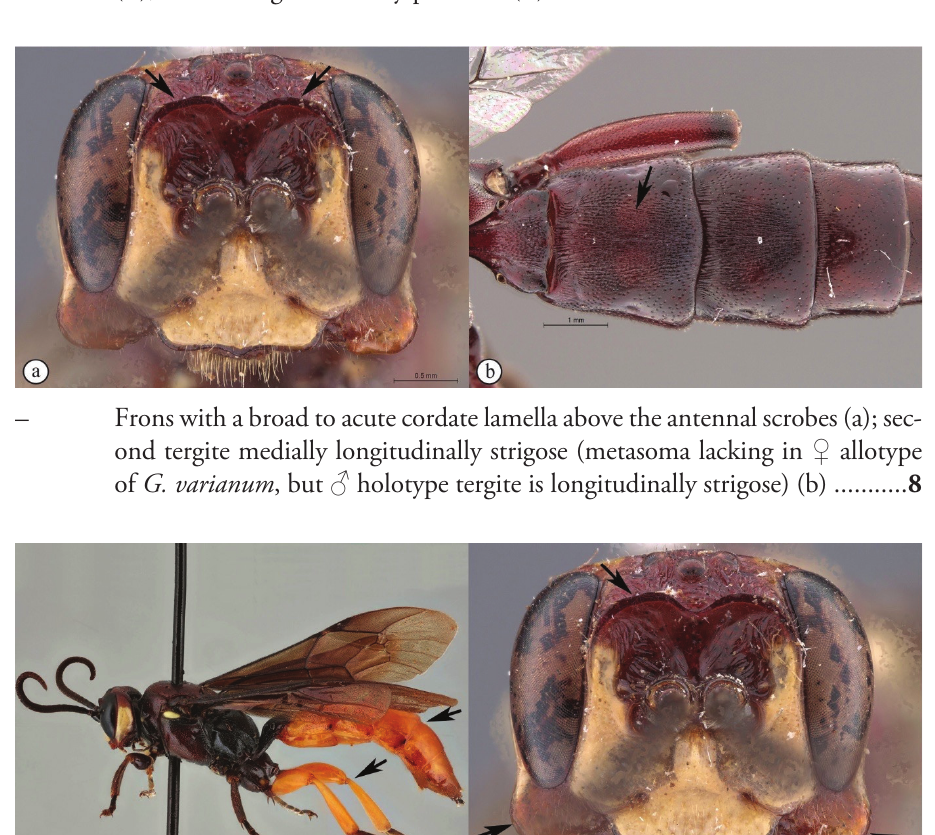
7 Frons with a forked, horn-like projecting carina above the antennal scrobes (A); second tergite medially punctate (B) ................ G. rhinoceros Heinrich